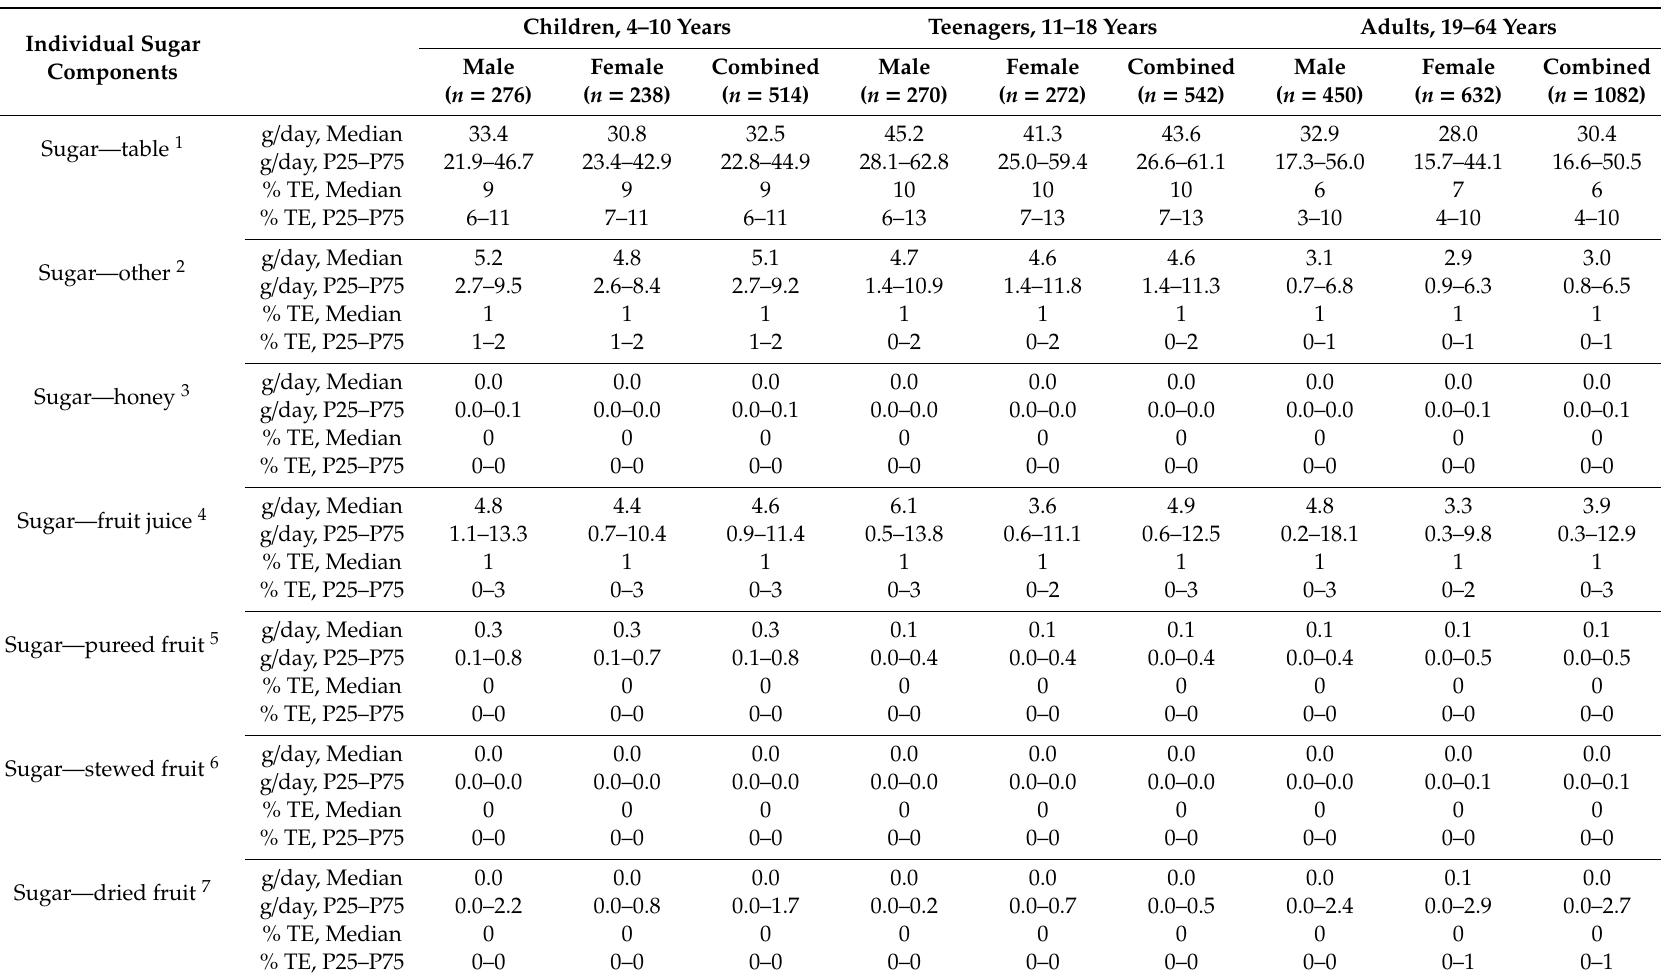
Table 2. Daily intakes of individual sugar components by age and sex (NDNS 2014–2016) (including consumers and